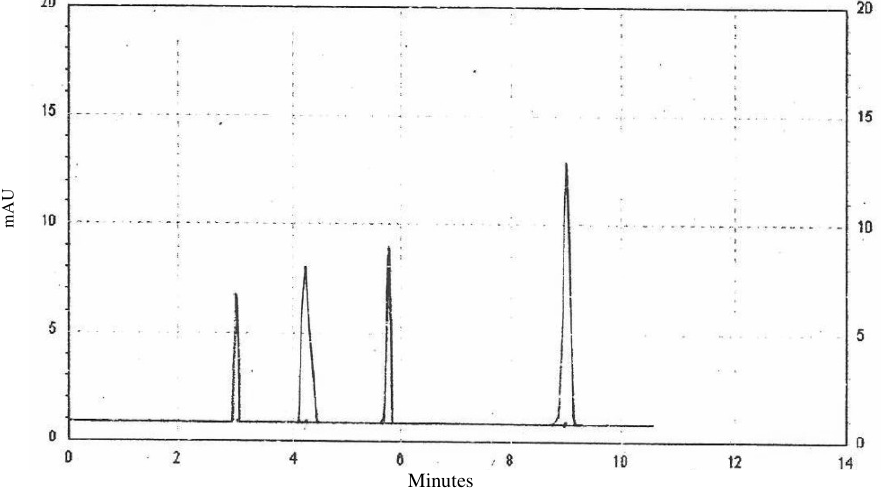
Figure 2. Chromatogram showing separation by RP-HPLC (1) Diclofenac sodium, (2) Paracetamol, (3) Lamotrigine and (4)